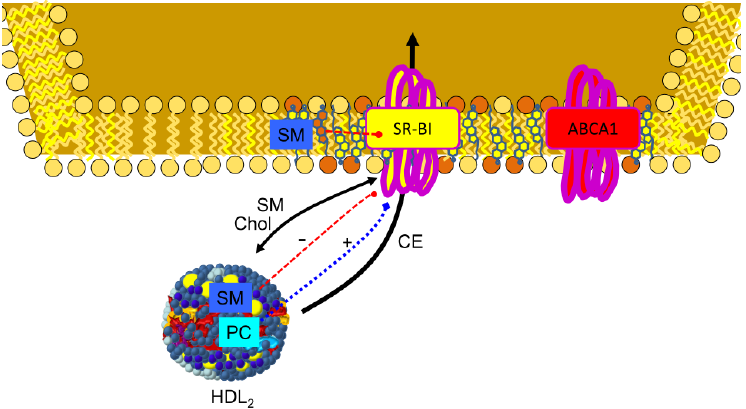
Figure 6. Influence of SM in delivering cholesterol to cells through the SR-BI receptor. SR-BI mediates cholesterol ester influx by the cells but also bidirectional flux of unesterified cholesterol and phospholipids between HDL and cells. Both cell membrane and HDL SM inhibit SR-BI transport activity, while HDL PC stimulates its transport activity